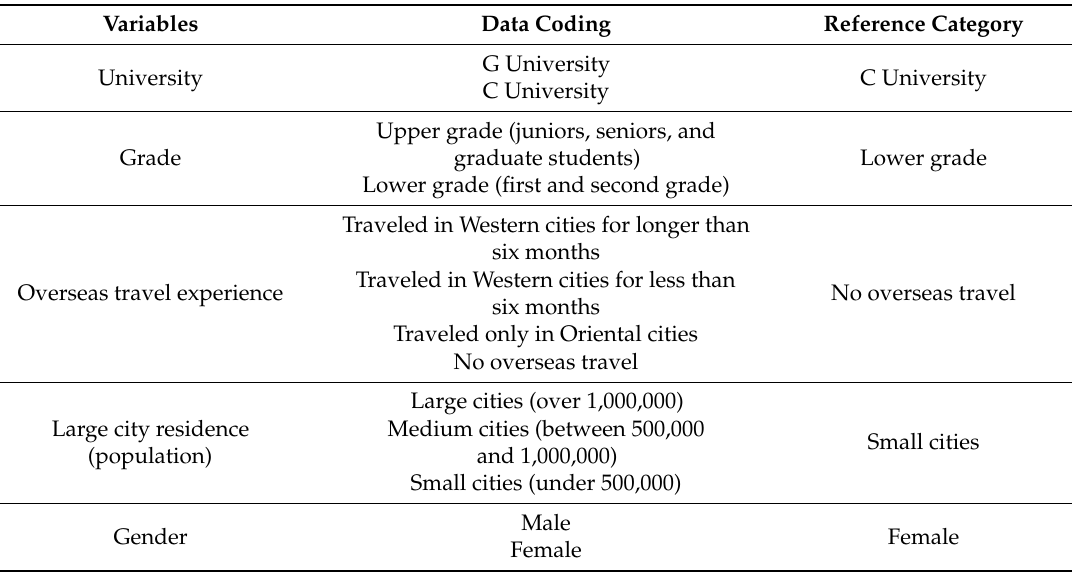
Table 1. Control variables, data coding, and reference